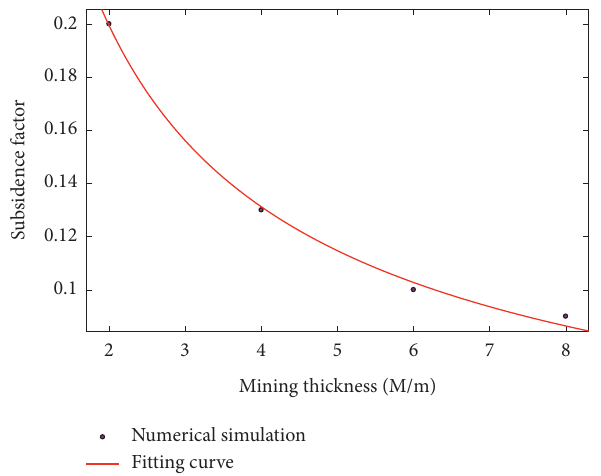
Figure 7: Relationship between the subsidence factor and the mining thickness.